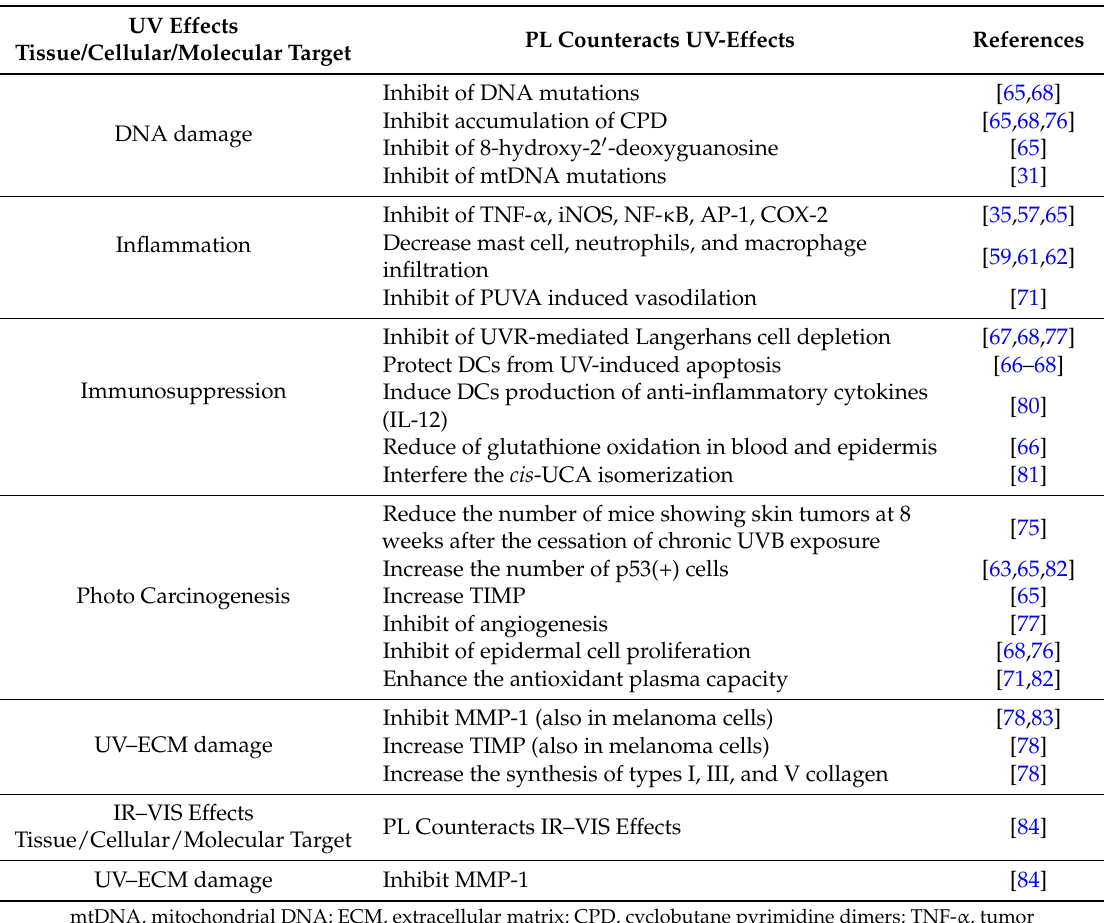
Solar (ultraviolet (UV), infrared (IR), and visible light (VIS)) protection effects of Polypodium leucotomos (PL) and molecular